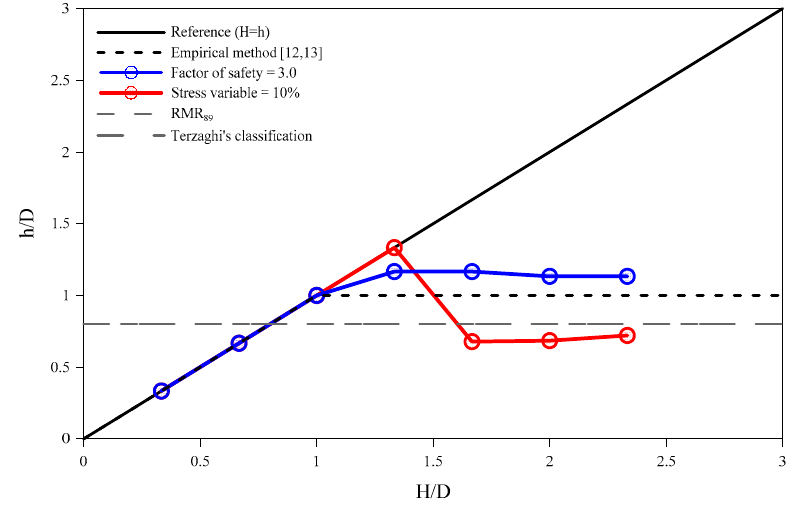
Figure 14. Relation between H / D and h / D for rock mass class V considering the factor of safety and stress variable.